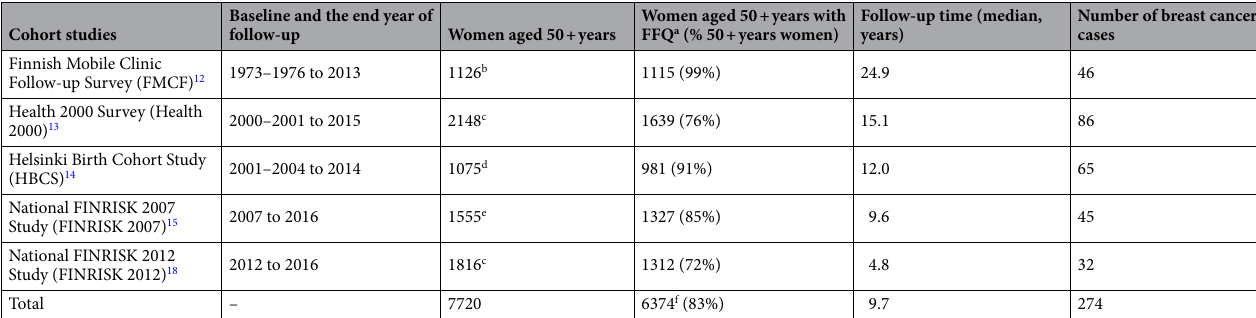
Table 1. Cohort studies included in the combined analyses of the association between diet quality indices and postmenopausal breast cancer risk. a Food frequency questionnaire. b Dietary subgroup with a dietary history interview. c Food frequency questionnaire was given for those who participated in health examination at study site. d Clinical subgroup. e Dietary subgroup with a food frequency questionnaire. f 77% of women aged 50 + years had accepted